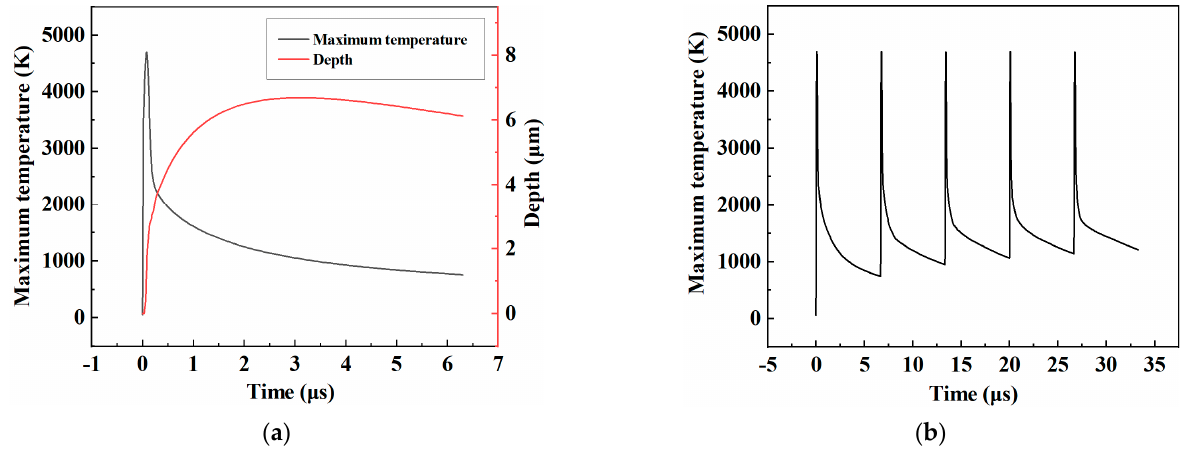
Figure 5. Maximum temperature and ablation depth variation. ( a ) Maximum temperature and ablation depth variation in single pulse cycle. ( b ) Maximum temperature variation in five pulse cycles.